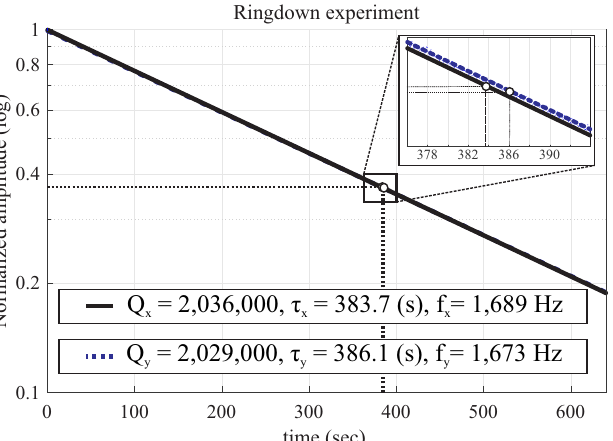
Figure 9. Ringdown time measurements revealed the Q-factor as high as 2 million, on both X-axis and Y-axis, after UHV